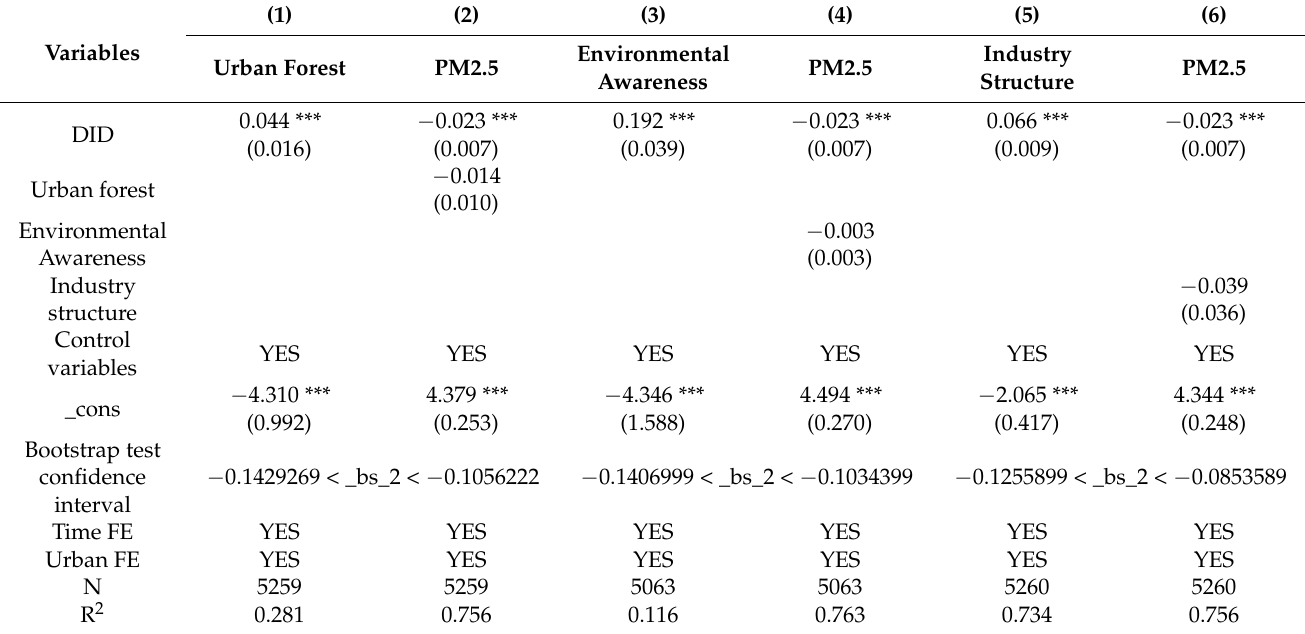
Table 7. Results of intermediate effect